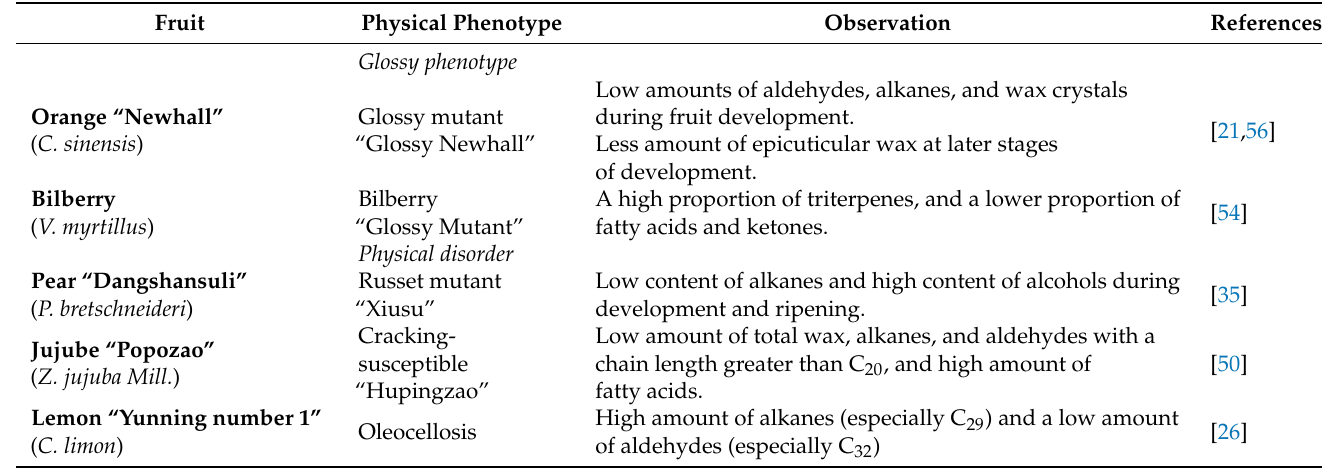
Table 4. Cuticle composition associated with physical skin disorders of fleshy